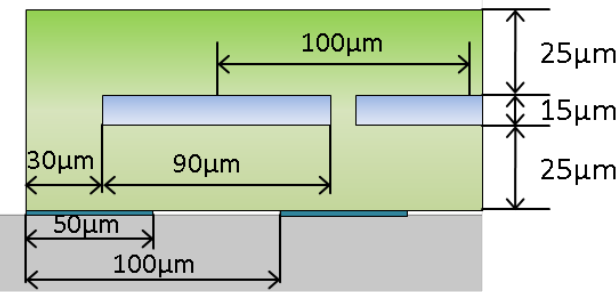
Figure 1. Dimensions of the microfluidic structure and the SAW electrodes geometry.